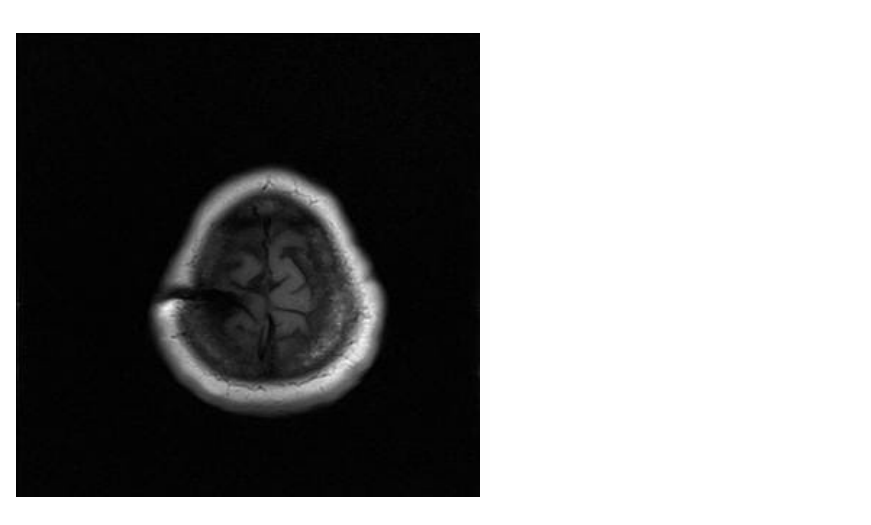
Figure 1. Preoperative T1 MRI sequence showing a previous brain convexity placement of an electrode at the coronal region.